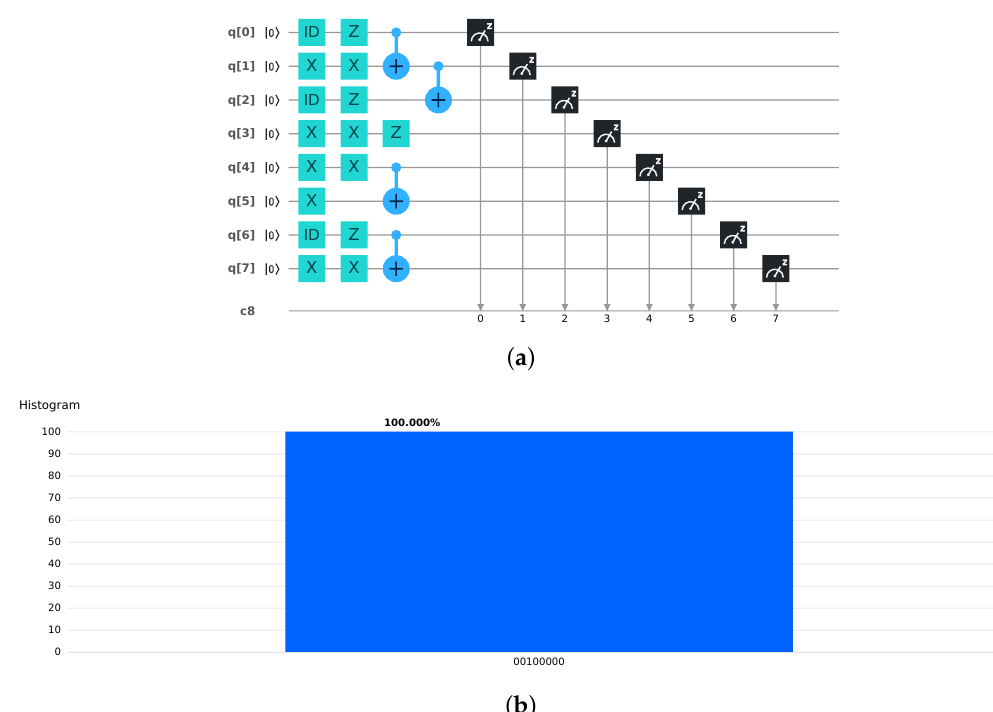
ϕ based on K AT . ( a ) Quantum circuit for the encryption | (cid:105) M (cid:48)(cid:48)